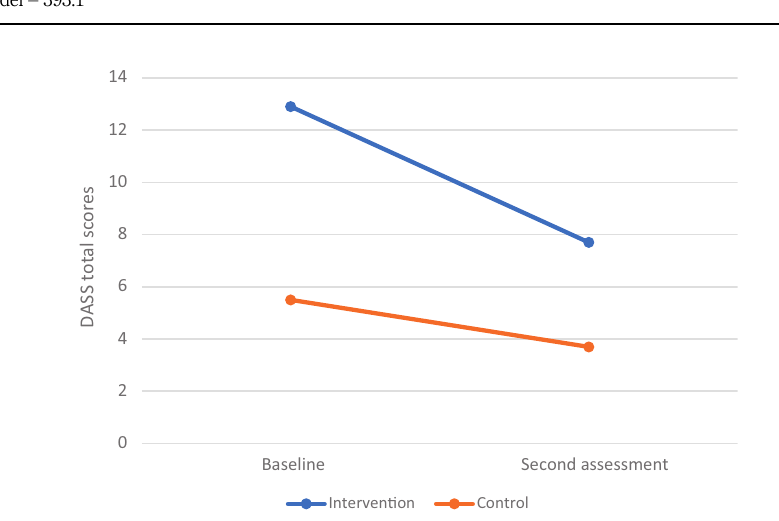
Figure 2. Difference of the total DASS score based on thebaselineandsecond assessment between the intervention and control